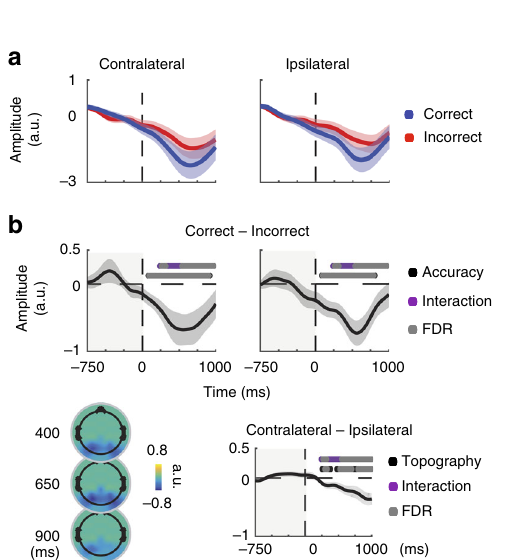
Fig. 3 Topographically selective increases in post-stimulus amplitude predict accuracy. a The timecourse of alpha amplitude on correct (blue) and incorrect (red) trials in the contralateral and ipsilateral electrodes indicated in Fig. 1. Amplitude timecourses are baselined to − 1000 to − 750 ms pre-stimulus, and shaded areas indicate ± 1 SEM within subject. b Alpha amplitude decreases more on correct compared to incorrect trials in both contralateral and ipsilateral electrodes. Furthermore, the decrease in alpha amplitude is topographically selective, displaying larger decreases contralateral to the target. Topographic plots indicate the difference between correct and incorrect trials averaged over 100 ms bins centered on 0.4, 0.65, and 0.9 s after stimulus onset. All dots indicate signi fi cance from zero, evaluated by comparing the obtained t- value with a null distribution of t -values computed by shuf fl ing the condition labels 10,000 times. This analysis was done on a timepoint-by-timepoint basis from stimulus onset to + 1 s, as indicated by the non-shaded areas (see Methods). Main effects with P < 0.05 are indicated in black, and gray dots indicate signi fi cance after FDR correction at P =